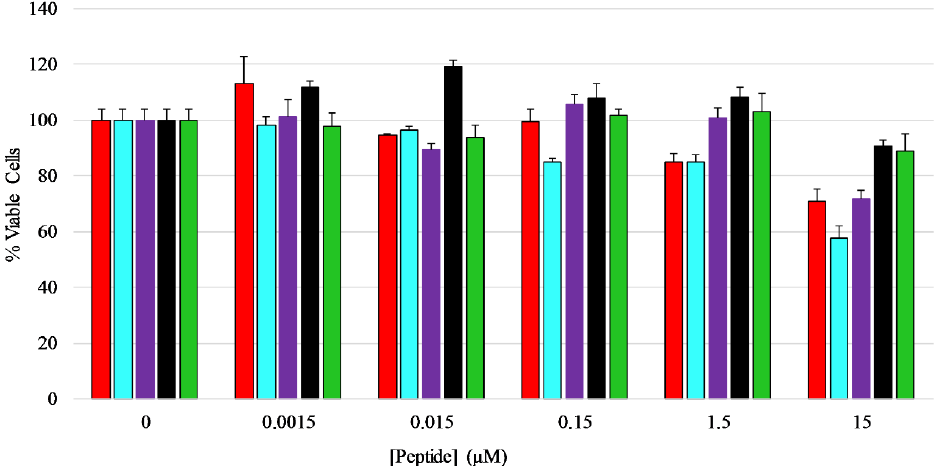
Figure 6. Mammalian cell viability assay—Effects of AP3 peptides on HEK-293 cell viability assayed by MTT metabolic breakdown. A standard density of HEK-293 cells was incubated with serially